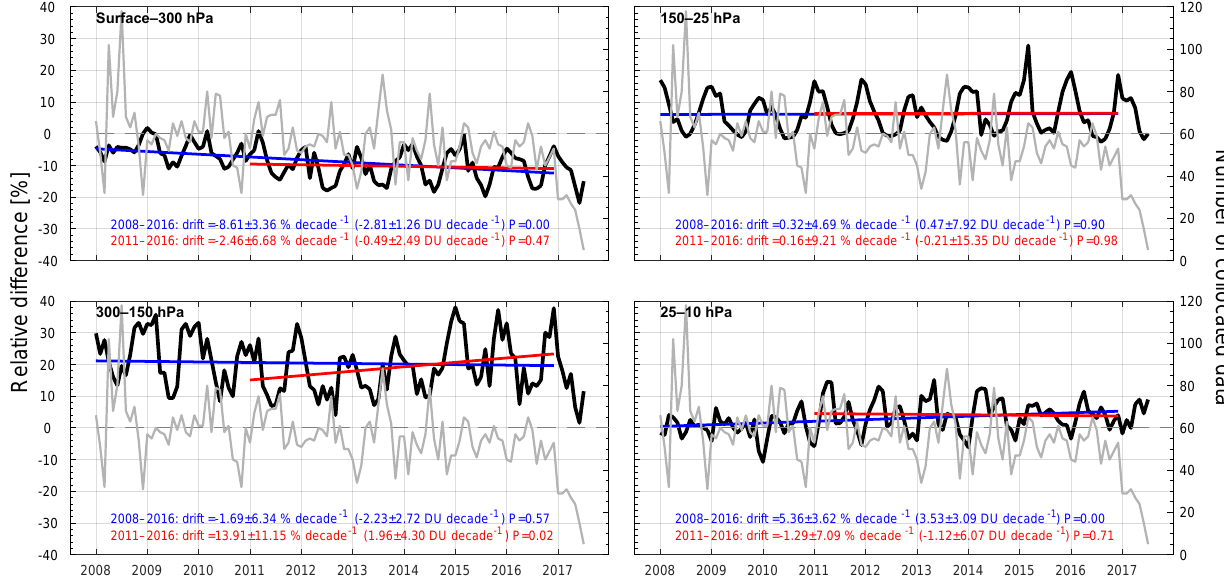
Figure 16. Time series of the monthly mean relative differences between IASI-A and ozonesonde O 3 measurements for different partial columns for the period from 2008 to 2017 for the Northern Hemisphere. The number of collocated data is also displayed in gray. The decadal drift, its 2 σ standard deviation in percent and the P value are indicated on each panel for two periods: 2008–2016 (blue) and 2011–2016